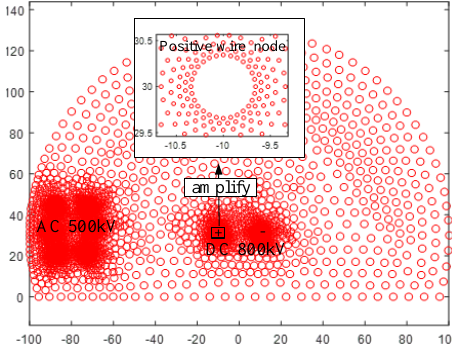
Figure 7. The calculation node of the MLPG.